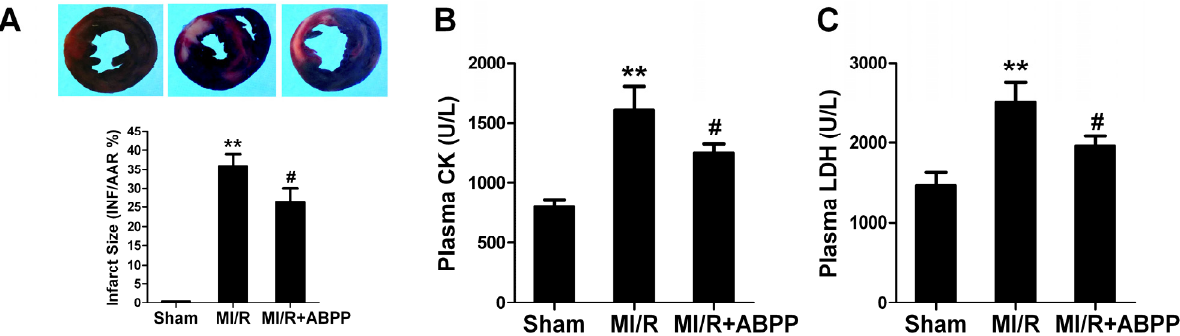
Figure 2. Achyranthes bidentata polypeptides (ABPP) preconditioning reduced infarct size, plasma creatine kinase (CK) and lactate dehydrogenase activities (LDH) in rats subjected to myocardial ischemia/reperfusion. ( A ) Myocardial infarct size expressed as percentage of area-at-risk (AAR); ( B ) Plasma creatine kinase (CK) levels; ( C ) Plasma lactate dehydrogenase (LDH) levels. MI/R, myocardial ischemia/reperfusion (30 min/4 h); Sham, sham-operated; ABPP, Achyranthes bidentata polypeptides. Values presented